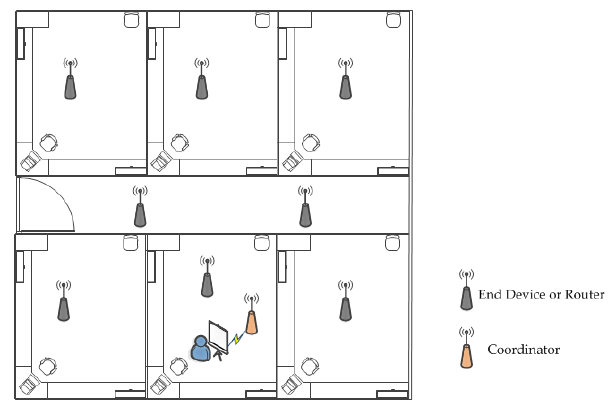
Figure 2. The plan of indoor monitoring.